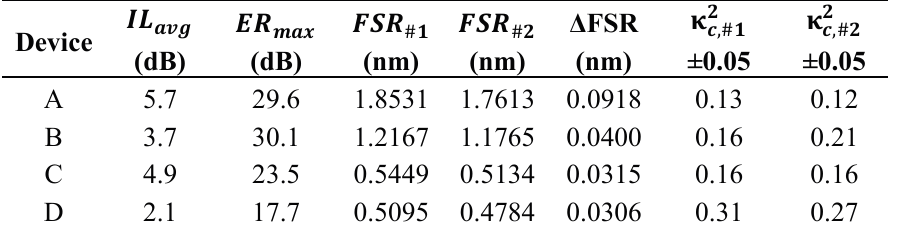
Table 3. Experimental optical parameters of fabricated SOI Vernier